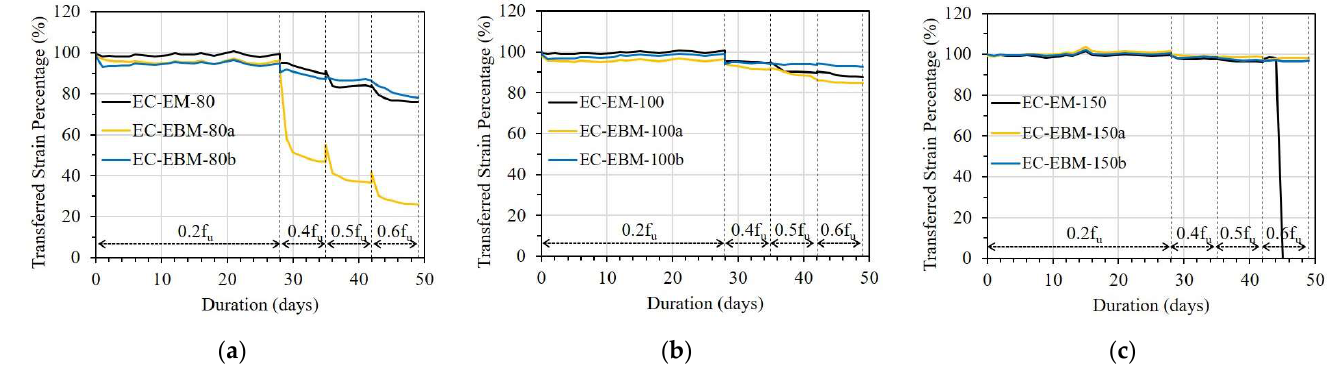
Figure 14. Short-term creep effect on strain transfer in the EC specimen with different bonding methods: ( a ) L = 80 mm; ( b ) L = 100 mm; and ( c ) L = 150 mm.